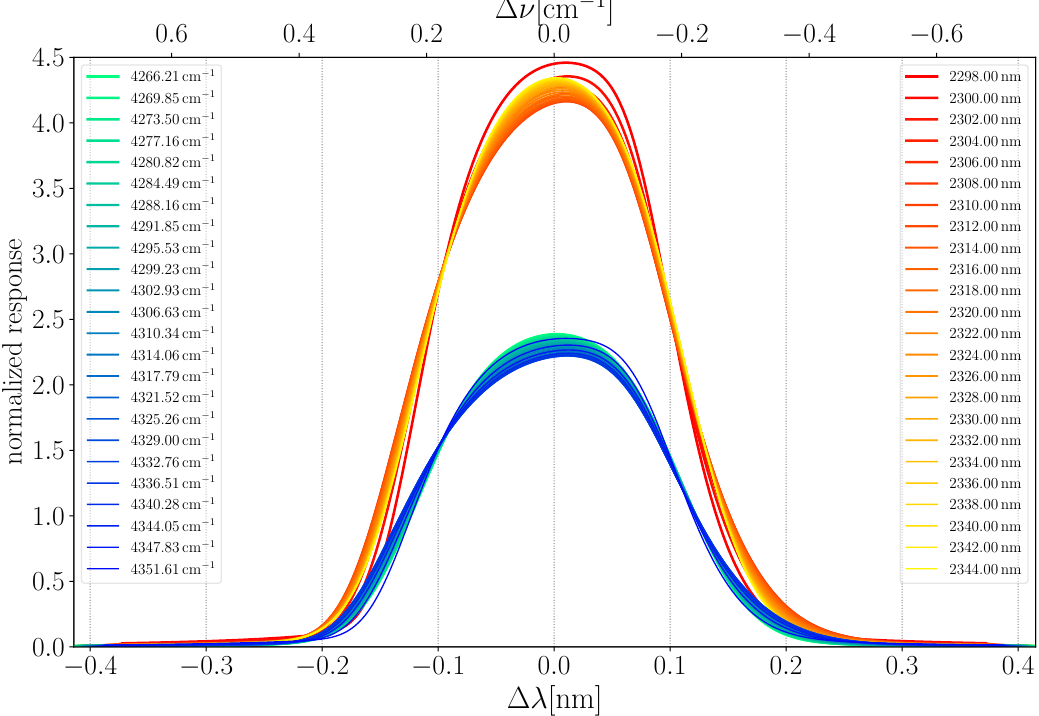
Figure 5. Tabulated responses for ground pixel 128 (out of 256) in TROPOMI’s band 7. The instrument spectral response functions (ISRFs) are normalized wavenumber ( x = ν ) domain,